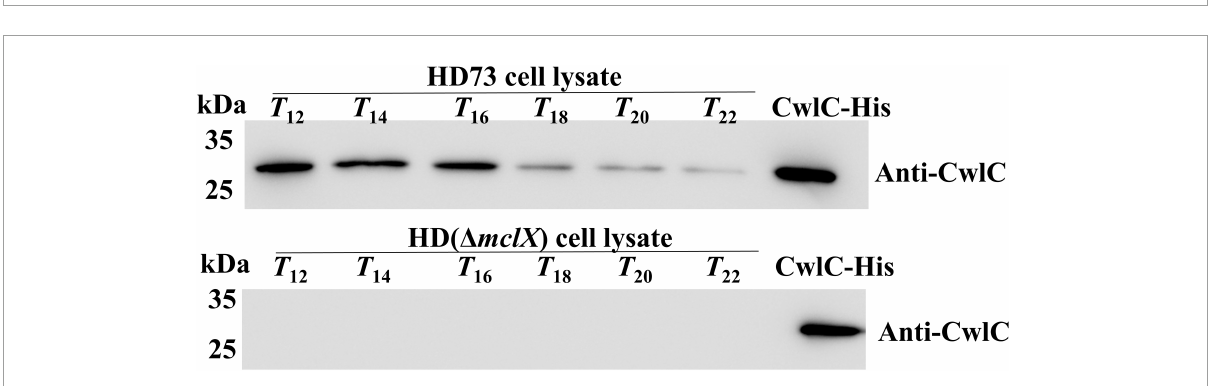
FIGURE5 CwlC was determined by Western blot in wild-type HD73 and HD ( (cid:49) mclX ) lysates. The same volumes were taken at the time points, and the same loading volumes were analyzed. CwlC-His served as positive control.